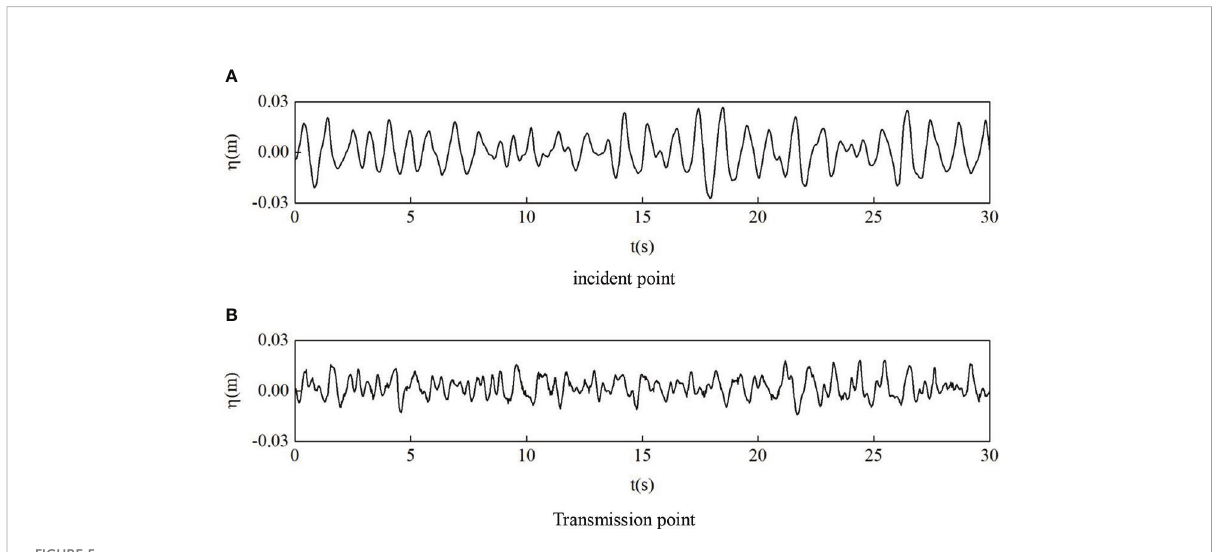
FIGURE 5 The measured water elevations (A) incident point (B) transmission